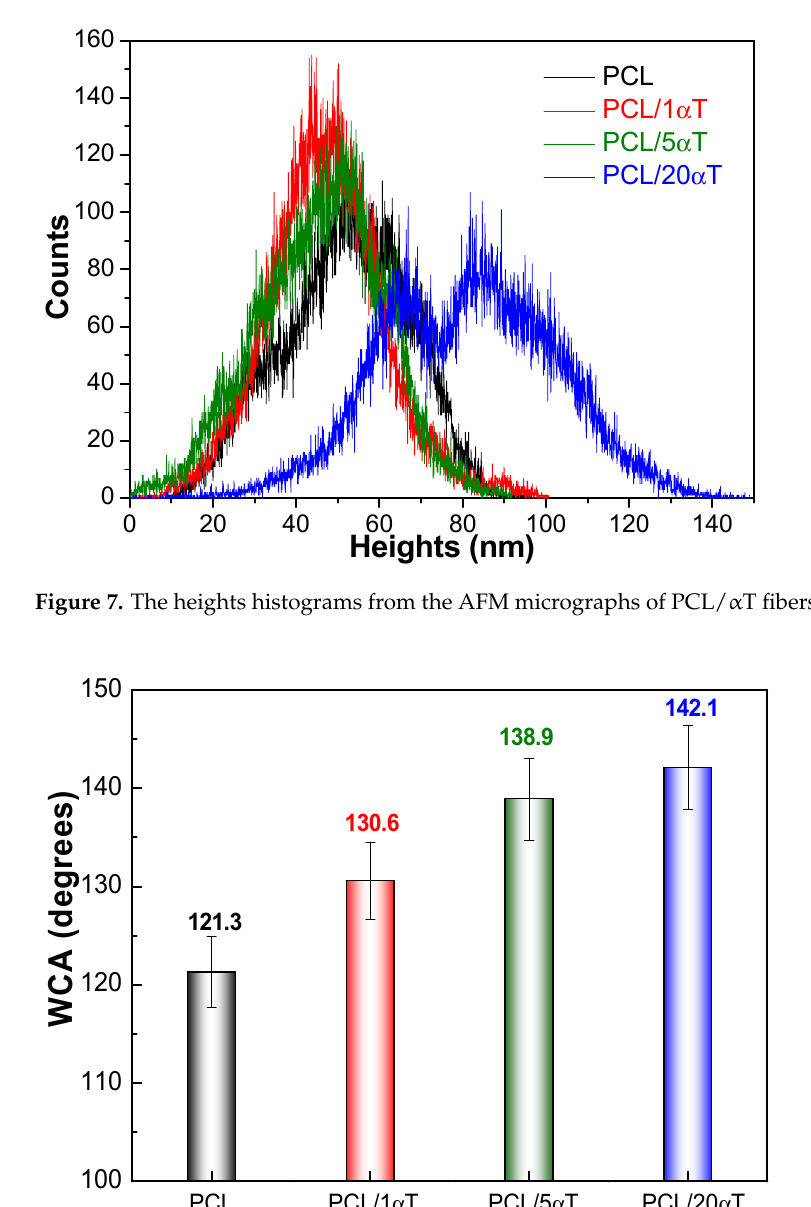
Molecules 2021 , 26 , x FOR PEER REVIEW